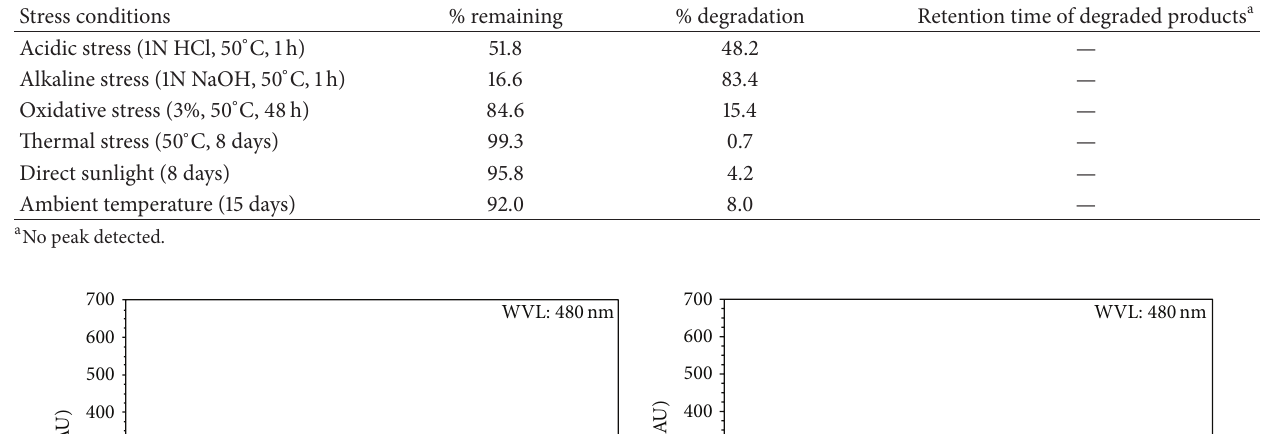
Table 5: Forced degradation study.